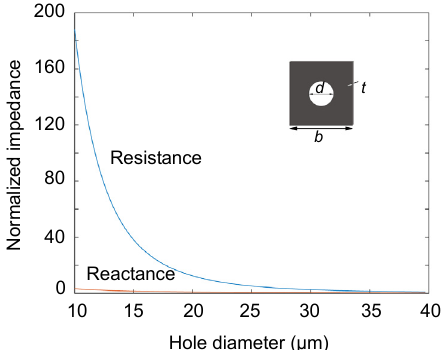
Fig. 2 | Normalized impedance versus the hole diameter d at a frequency of 10 kHz. b = t =100 μ m.